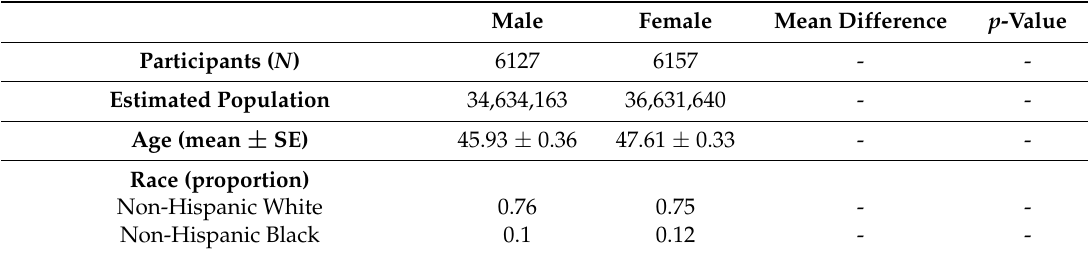
Table 1. Distribution of population demographics and lipid profiles by